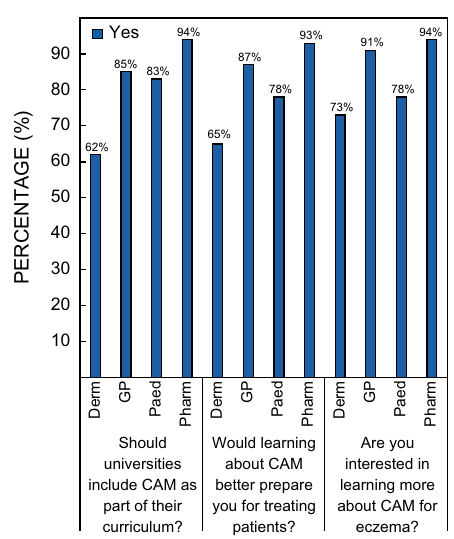
Figure 2: South African healthcare professionals’ perspectives on CAM education.